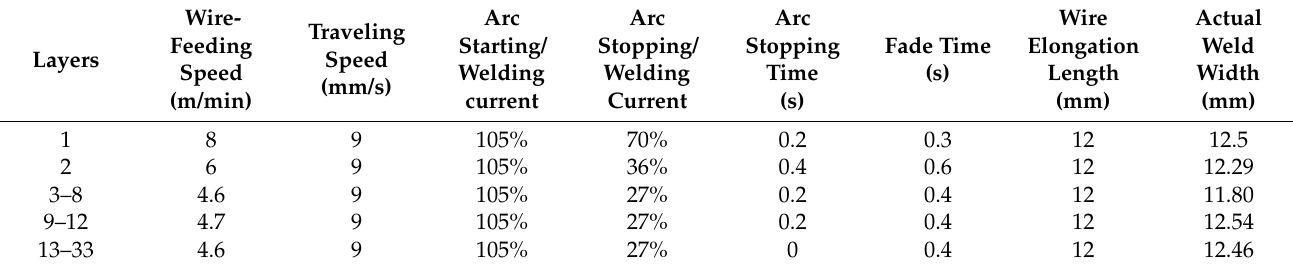
Table 2. Specific process parameters in additive